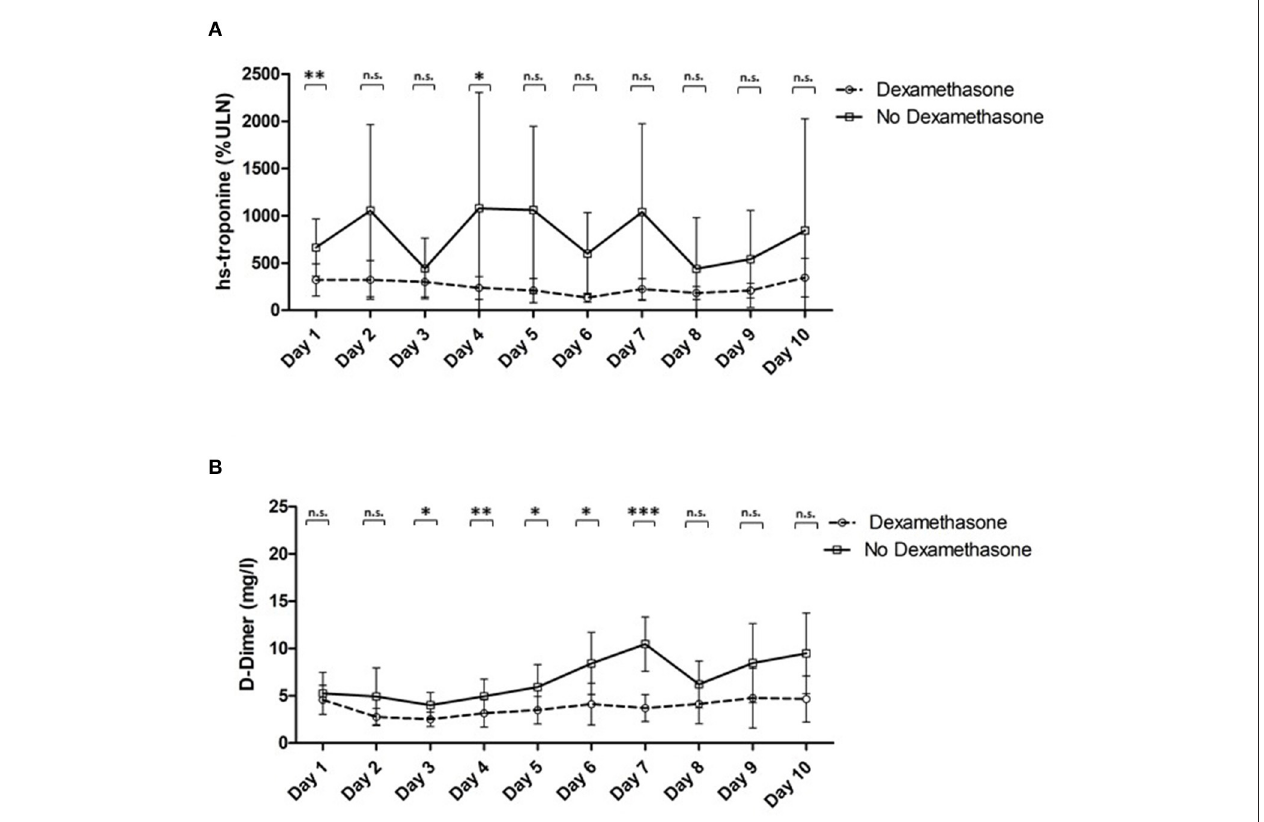
FIGURE 1 | (A) plasma levels of high sensitivity troponine normalized to %ULN in patients treated with dexamethasone vs. controls, (B) plasma levels of D-dimer in patients treated with dexamethasone vs. controls. *indicates a p of < 0.05; **a p of < 0.01 and *** a p of < 0.001; n.s., not significant. hs, high sensitivity; ULN, upper limit of